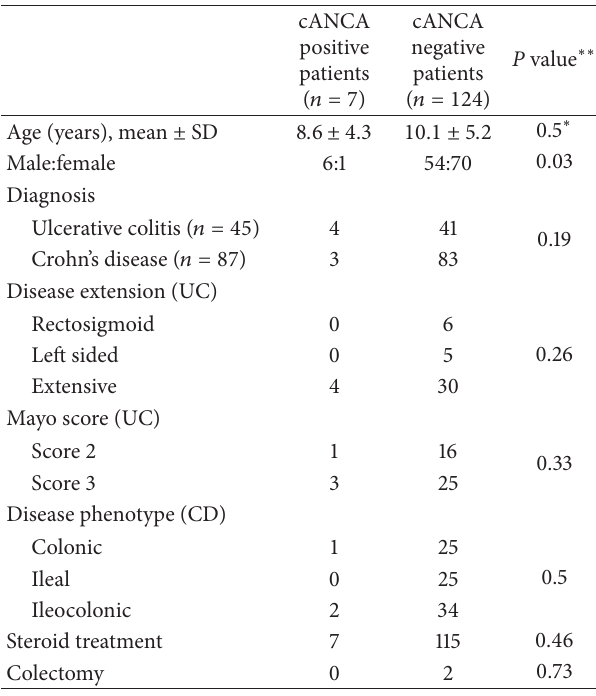
Table 3: Comparison of cANCA positive with cANCA negative